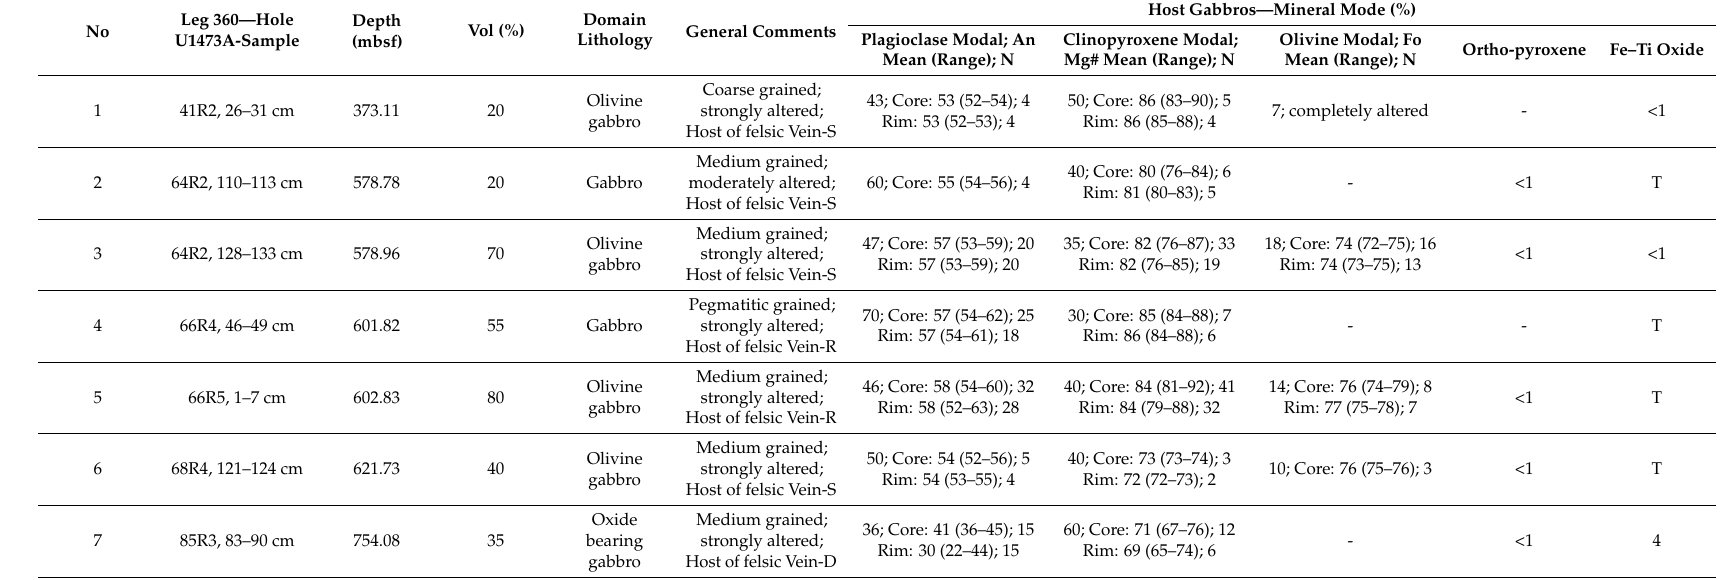
Table 1. Detailed characteristics of studied host gabbros samples—Hole